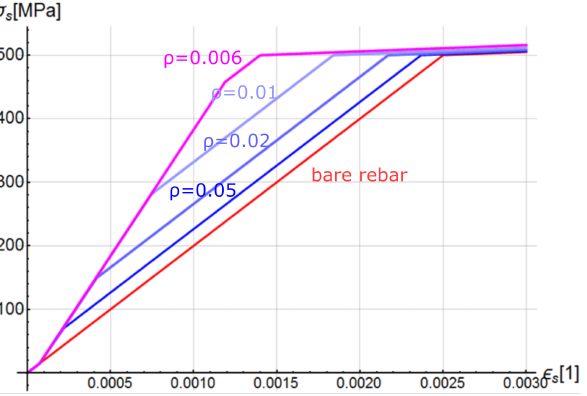
Figure 11. The σ – (cid:101) curves for the proposed generalised constitutive model of reinforcing steel— parametric study for different reinforcement ratios ρ ef f